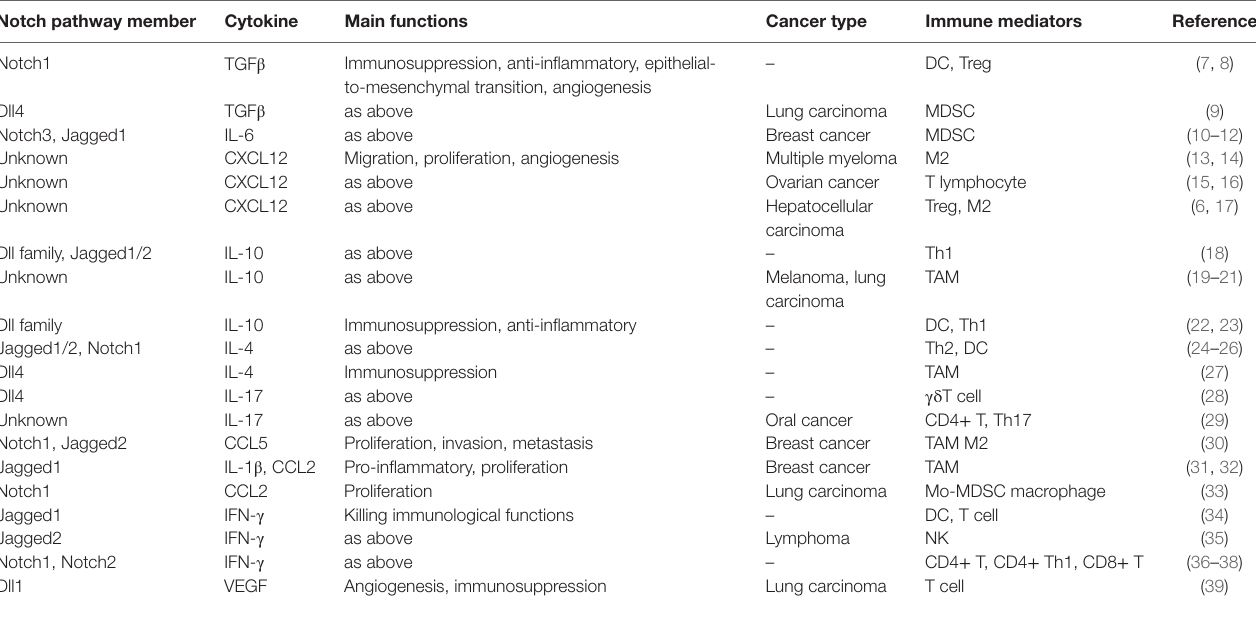
Table 1 | Effects of Notch signaling on the cytokine milieu and the immune system. Notch pathway